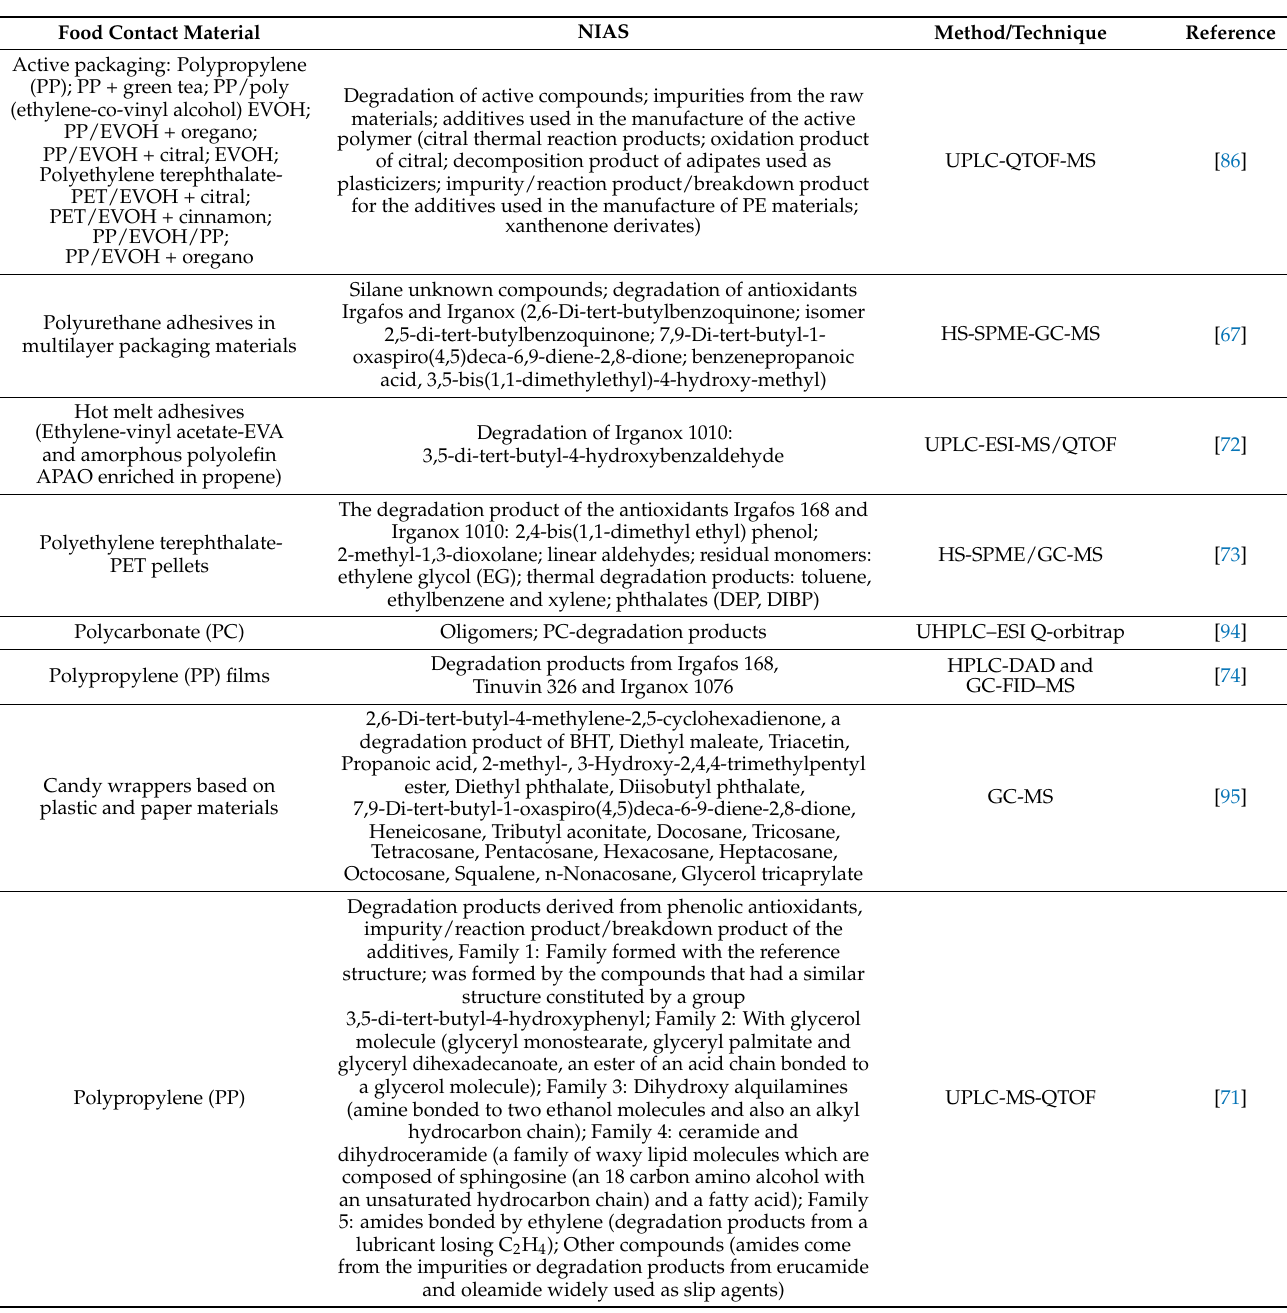
Table 4. Studies published in the literature on degradation/breakdown products (NIAS) Identification in different plastic food packaging. NIAS Method/Technique